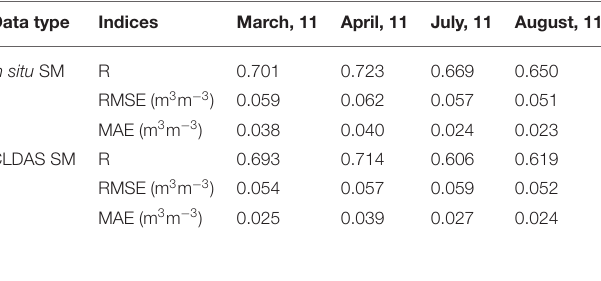
TABLE 4 | Statistical indices for the China Meteorological Administration Land Data Assimilation System (CLDAS) SM, in situ soil moisture (SM) and estimated SM.